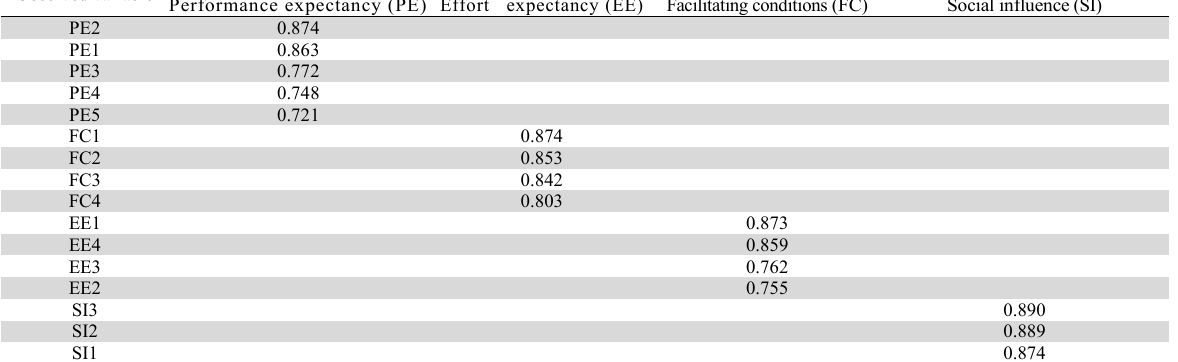
Results of the EFA Observed variable